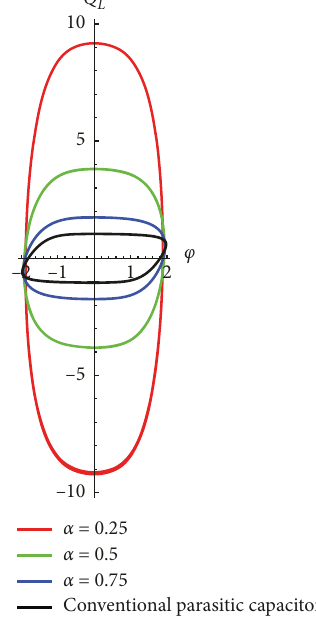
Figure 17: Q L vs φ of the memristor-inductor circuit with the nonlinear parasitic fractional/nonlinear conventional parasitic capacitor